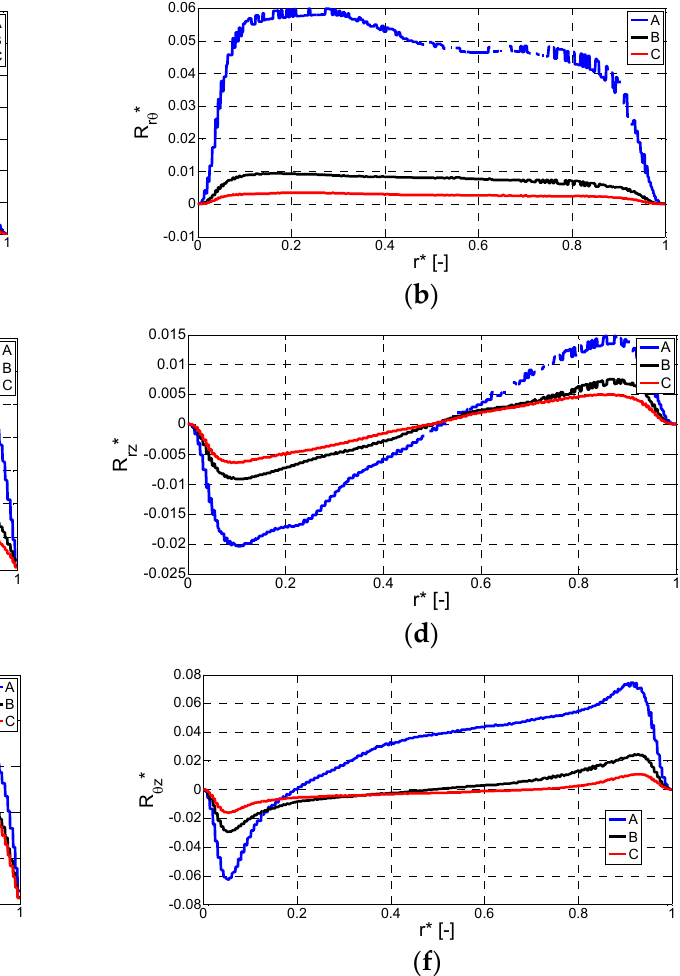
Therefore, the turbulent kinetic energy increases with N and the axial motion contributes to a large transfer of turbulent kinetic energy.